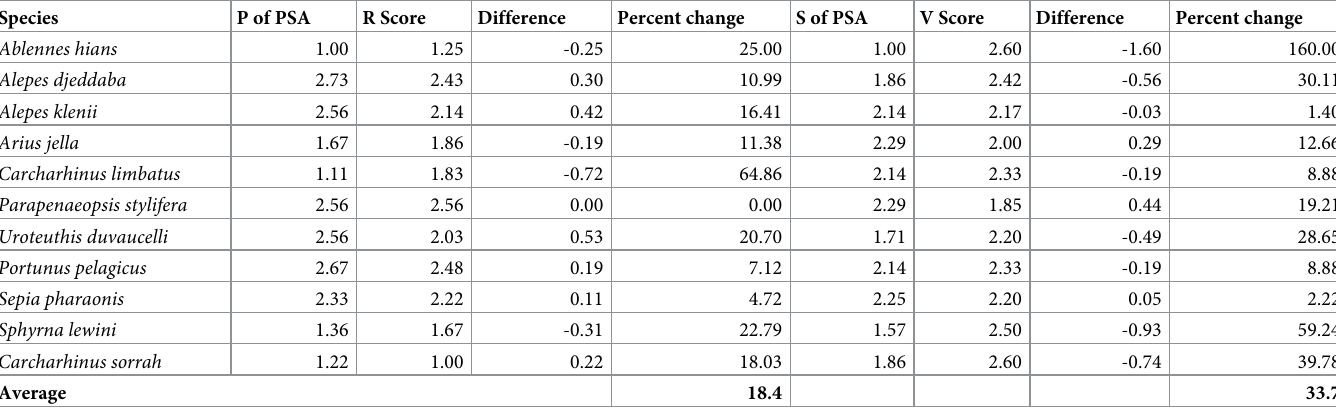
P indicates the productivity score of PSA and S indicates the susceptibility score of PSA. R and V scores are based on the current method. The percentage difference is based on absolute values.